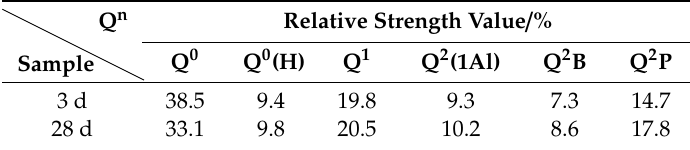
Table 2. Calculation results of deconvolution of Q n in 29 Si NMR